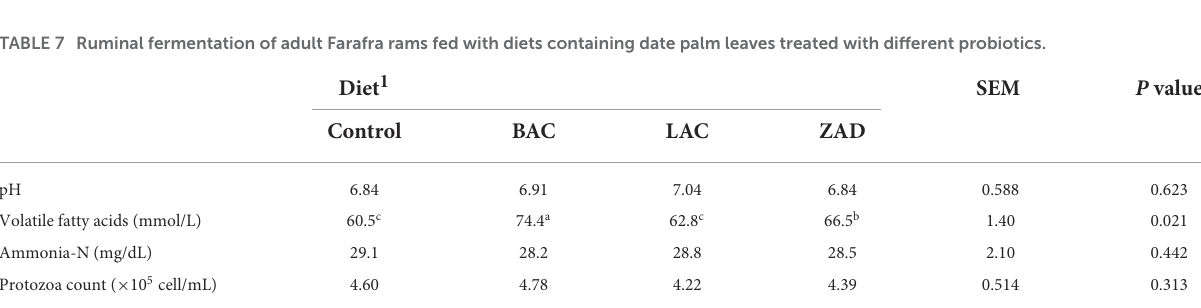
TABLE 7 Ruminal fermentation of adult Farafra rams fed with diets containing date palm leaves treated with different